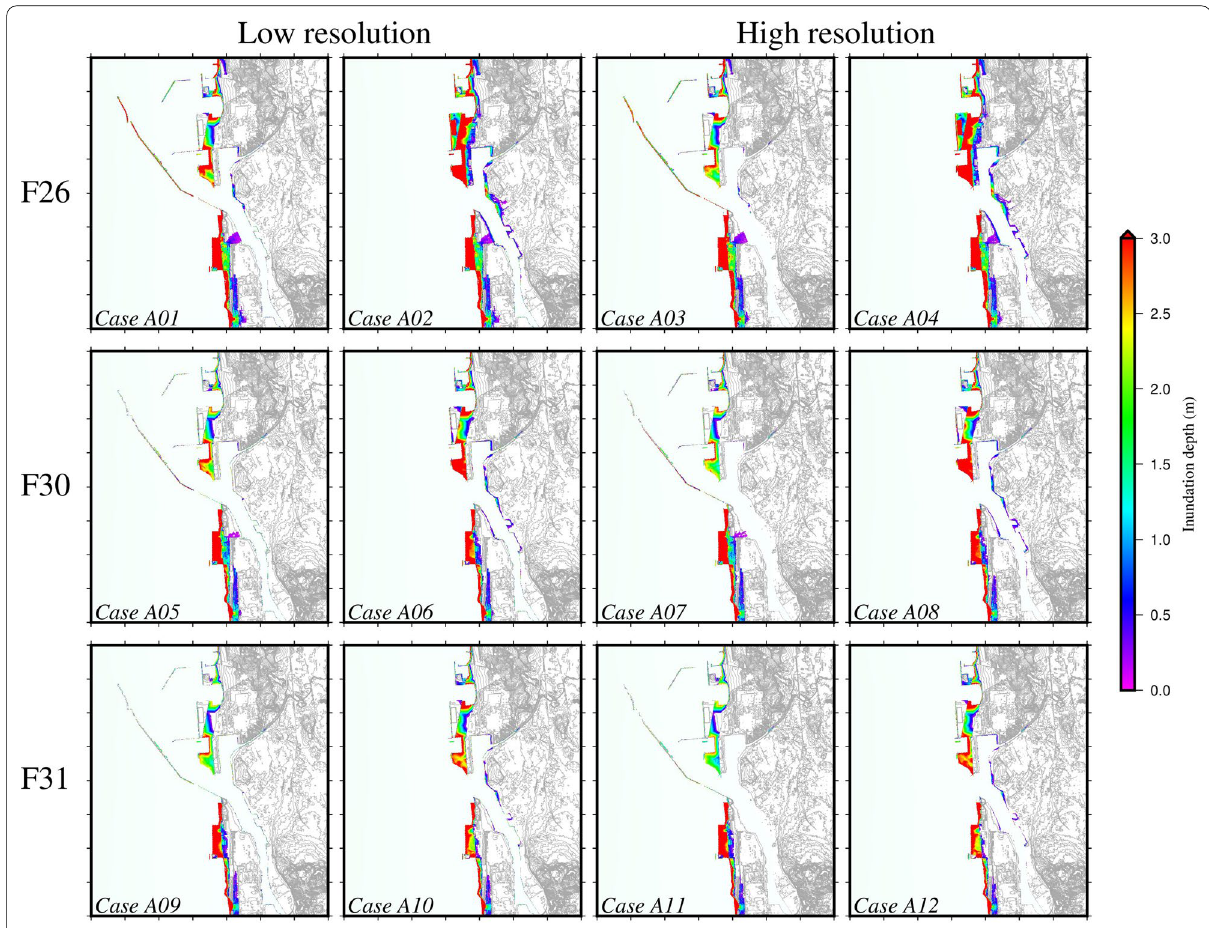
Fig. 8 Distribution of the maximum inundation depth at Akita City generated up to 45.0 min after the earthquakes. The displayed areas correspond to the areas specified by the blue squares in the top-right panel in Fig. 3; the thick interval was 1